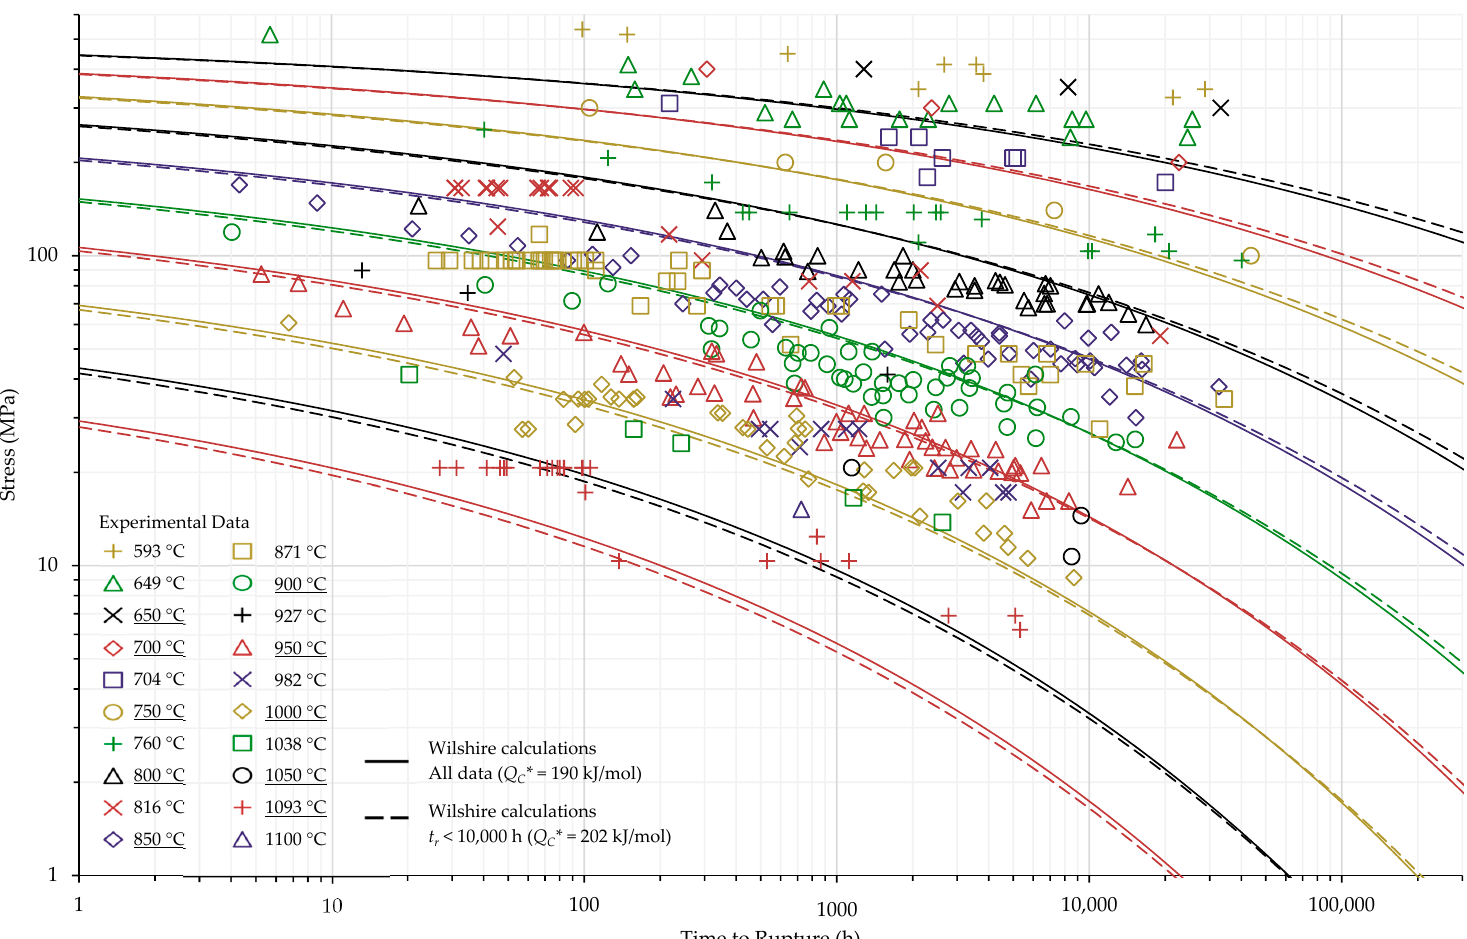
Figure 3. Single region calculations of the Wilshire equation with the lowest error for Inconel 617 shown at underlined temperatures.